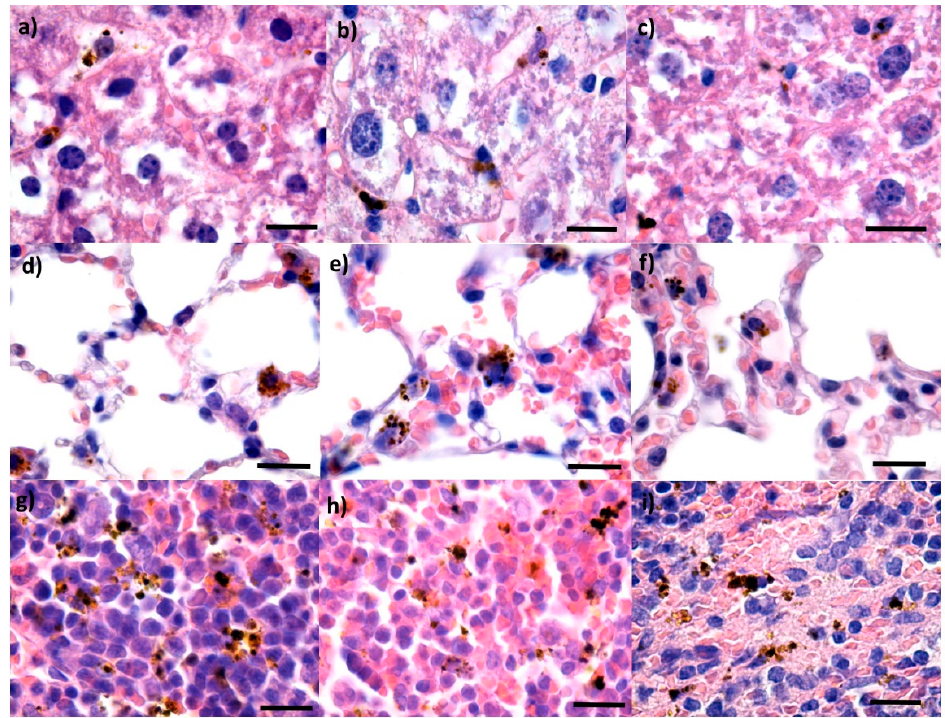
Figure 7. Cross-section through the ( a – c ) liver, ( d – f ) lungs, and ( g – i ) spleen from mice injected with Fe 3 O 4 ( a , d , g ), Fe 3 O 4 @PEG 20 K ( b , e , h ) and Fe 3 O 4 @PEG 35 K NPs ( c , f , i ), respectively, and harvested at 10 days after intravenous administration; normal morphology; Hematoxylin–Eosin staining; 1000× magnification, scale bar 25 μ m.